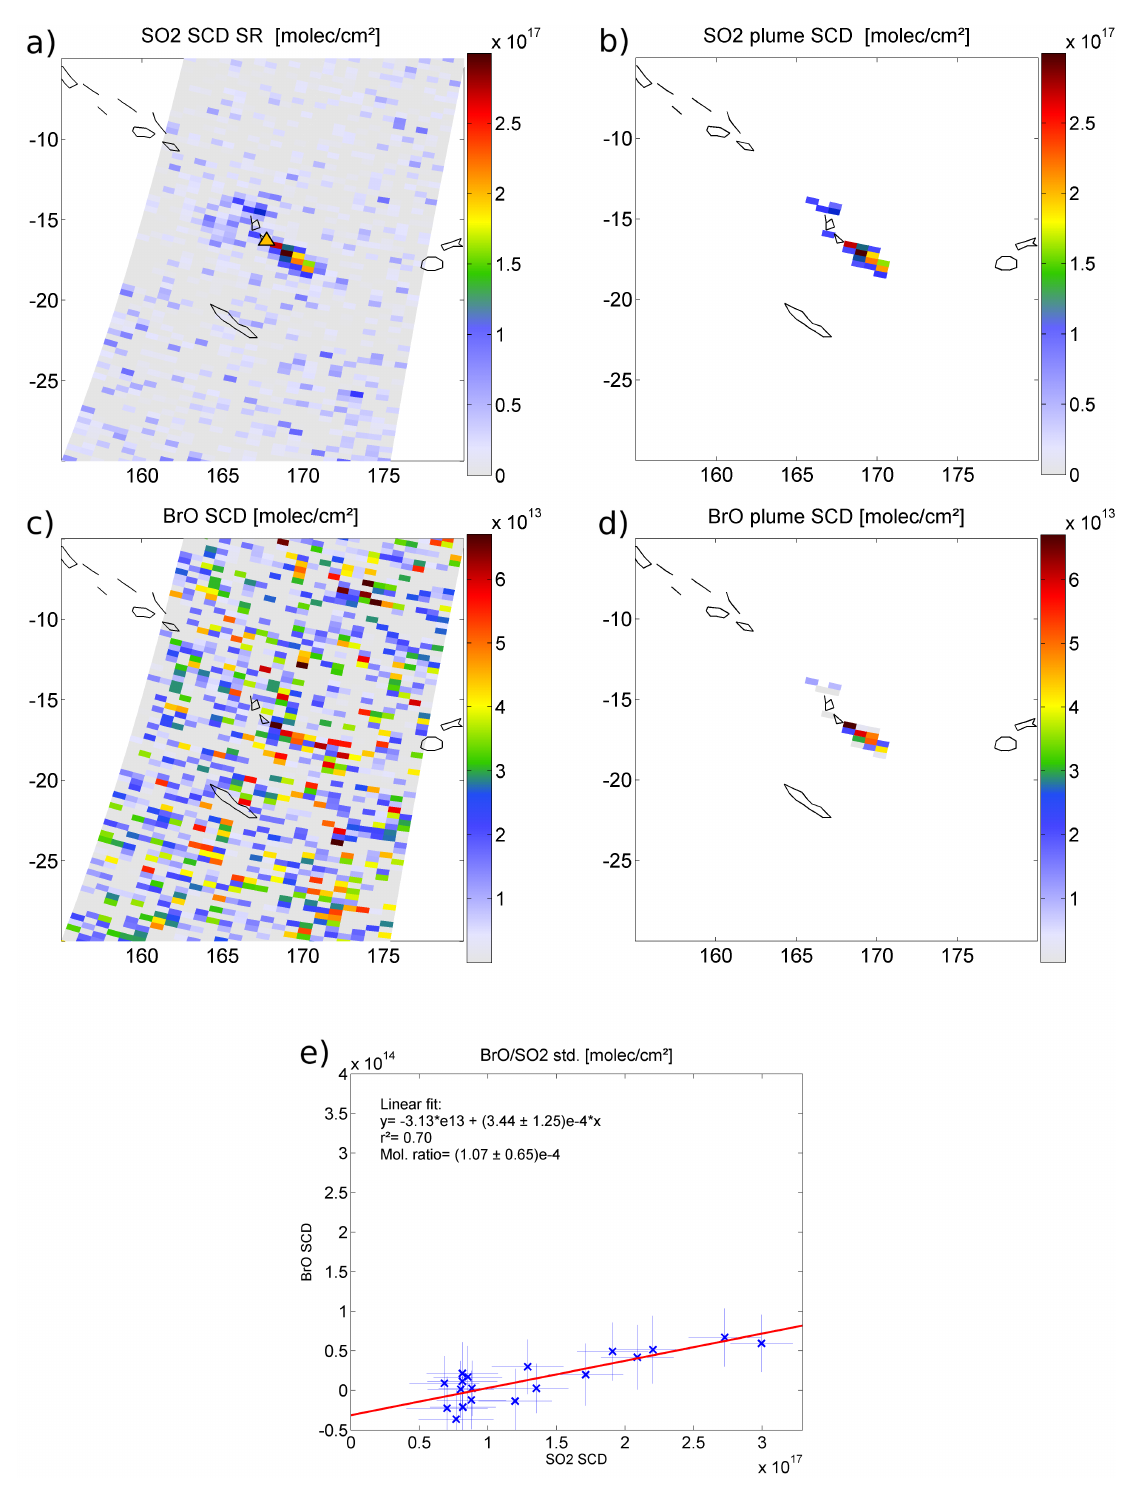
Fig. 15. SO 2 and BrO SCDs during a phase of enhanced passively degassing from the Ambrym volcano on 8 April 2010. While the SO 2 plume can be clearly seen in the satellite data (a) , enhanced BrO columns are not observed at first sight, since the large scatter indicates values around the instrument’s detection limit (c) . By focusing on the area of extracted SO 2 plume pixels ( b and d ), the correlation plot for both species shows a surprisingly clear linear correlation with a resulting r 2 =0.7 and a relatively high mean BrO/SO 2 ratio of (3.44 ± 1.25) × 10 − 4 from the bivariate linear fit (e)